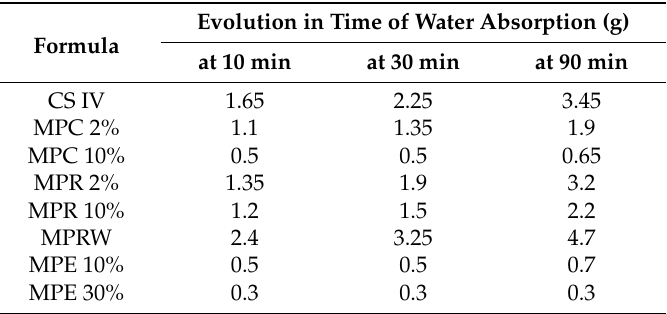
Table 1. Average values for water